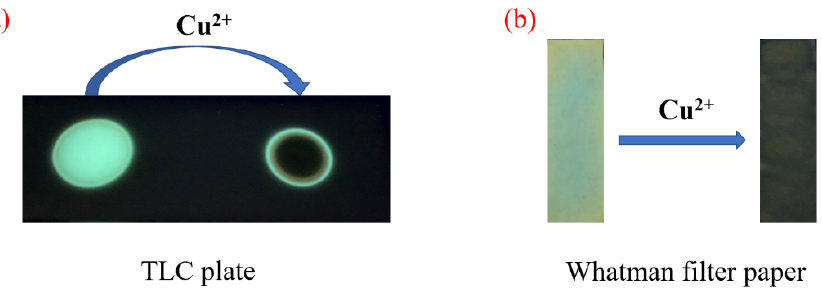
Figure 10. Fluorescence image (under 365 nm UV light) of sensor CPBI 2 adsorbed on a TLC